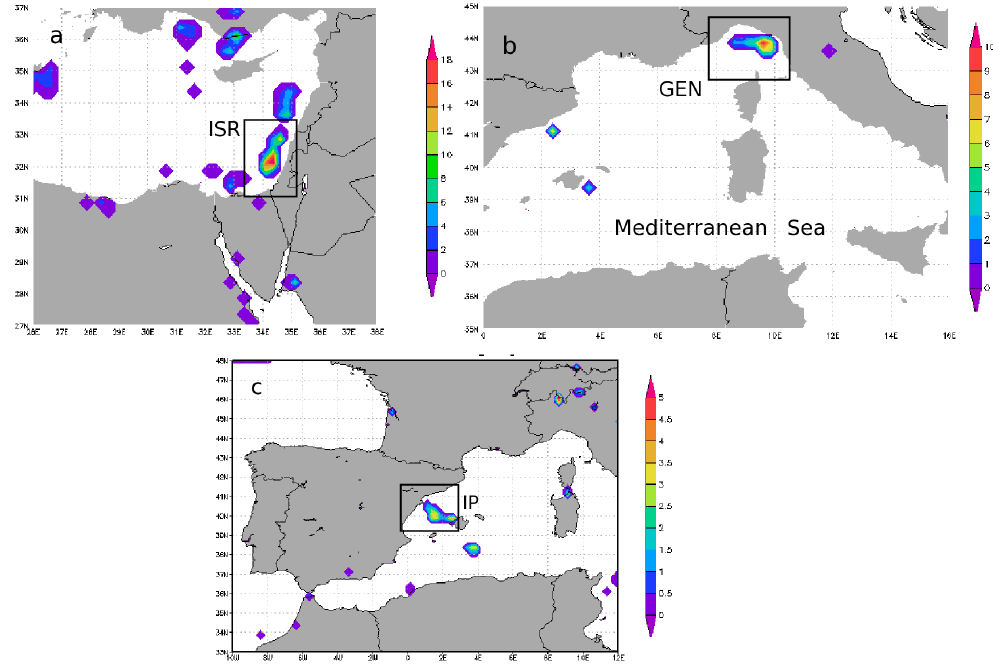
Figure 2. 3h accumulated precipitation estimated by TRMM between (a) 00:00 and 03:00UTC on 6 January 2011 for the ISR event, (b) 03:00 and 06:00UTC on 30 January 2008 for the GEN event, and (c) 03:00 and 06:00UTC on 6 September 2011 for the IP event. The solid rectangle indicates the approximate location of the domain used in the WRF